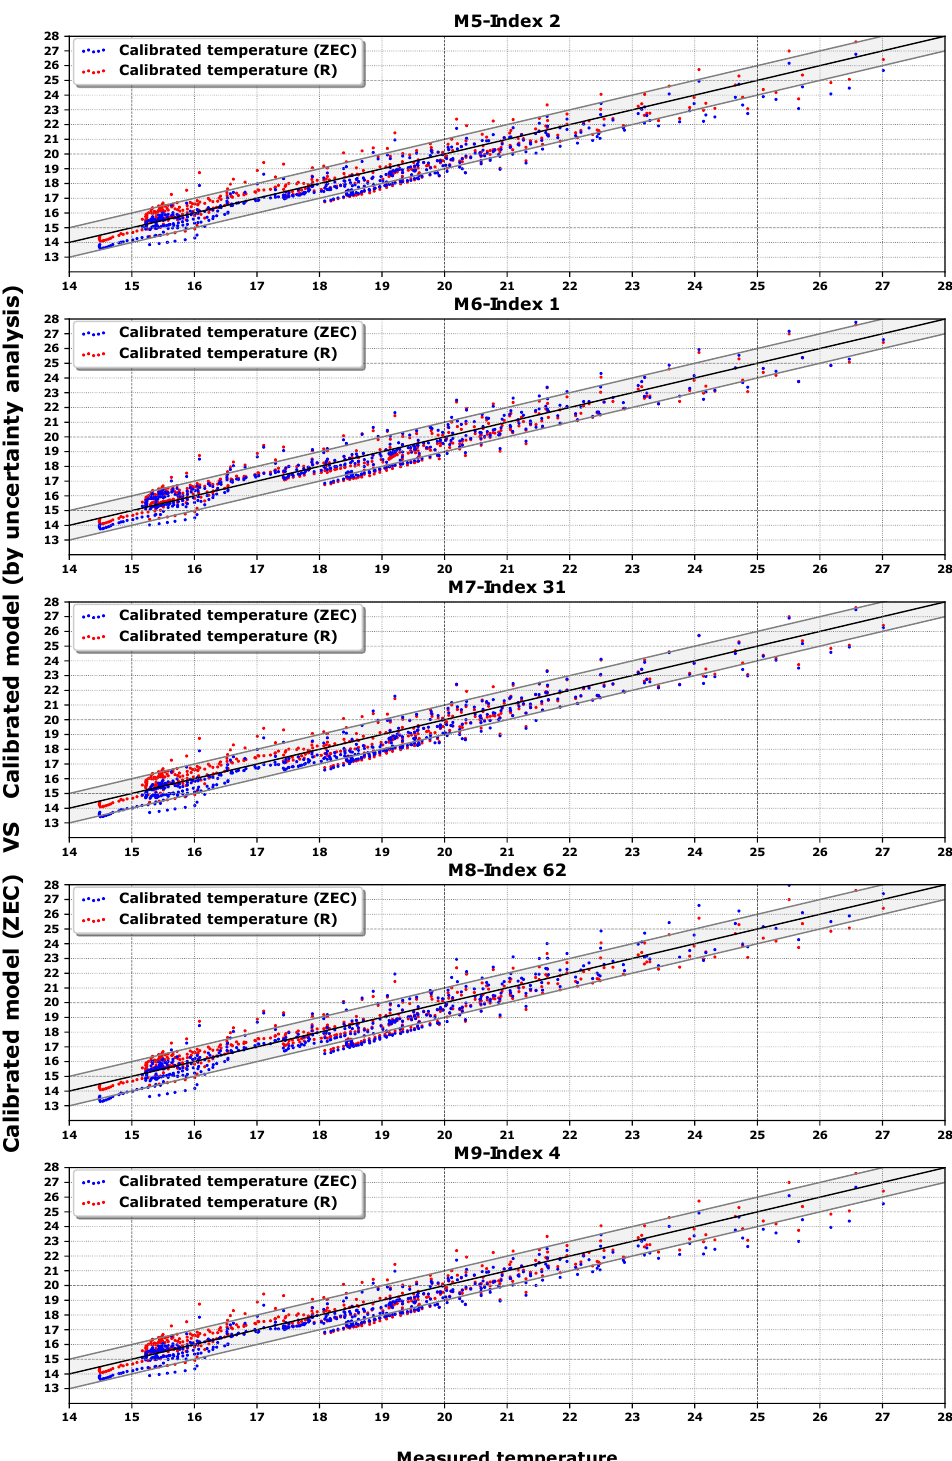
Figure 7. Temperature dispersion between the two calibration methodologies (ZEC vs. uncertainty